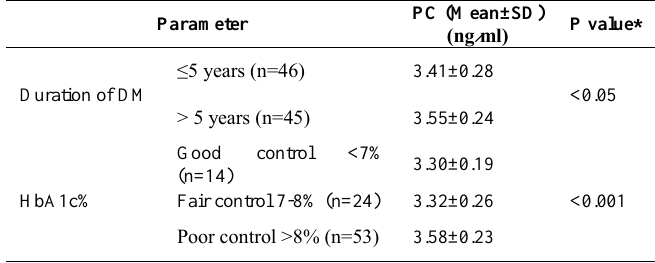
Table 4: Distribution of PC according to duration of DM and glycaemic control